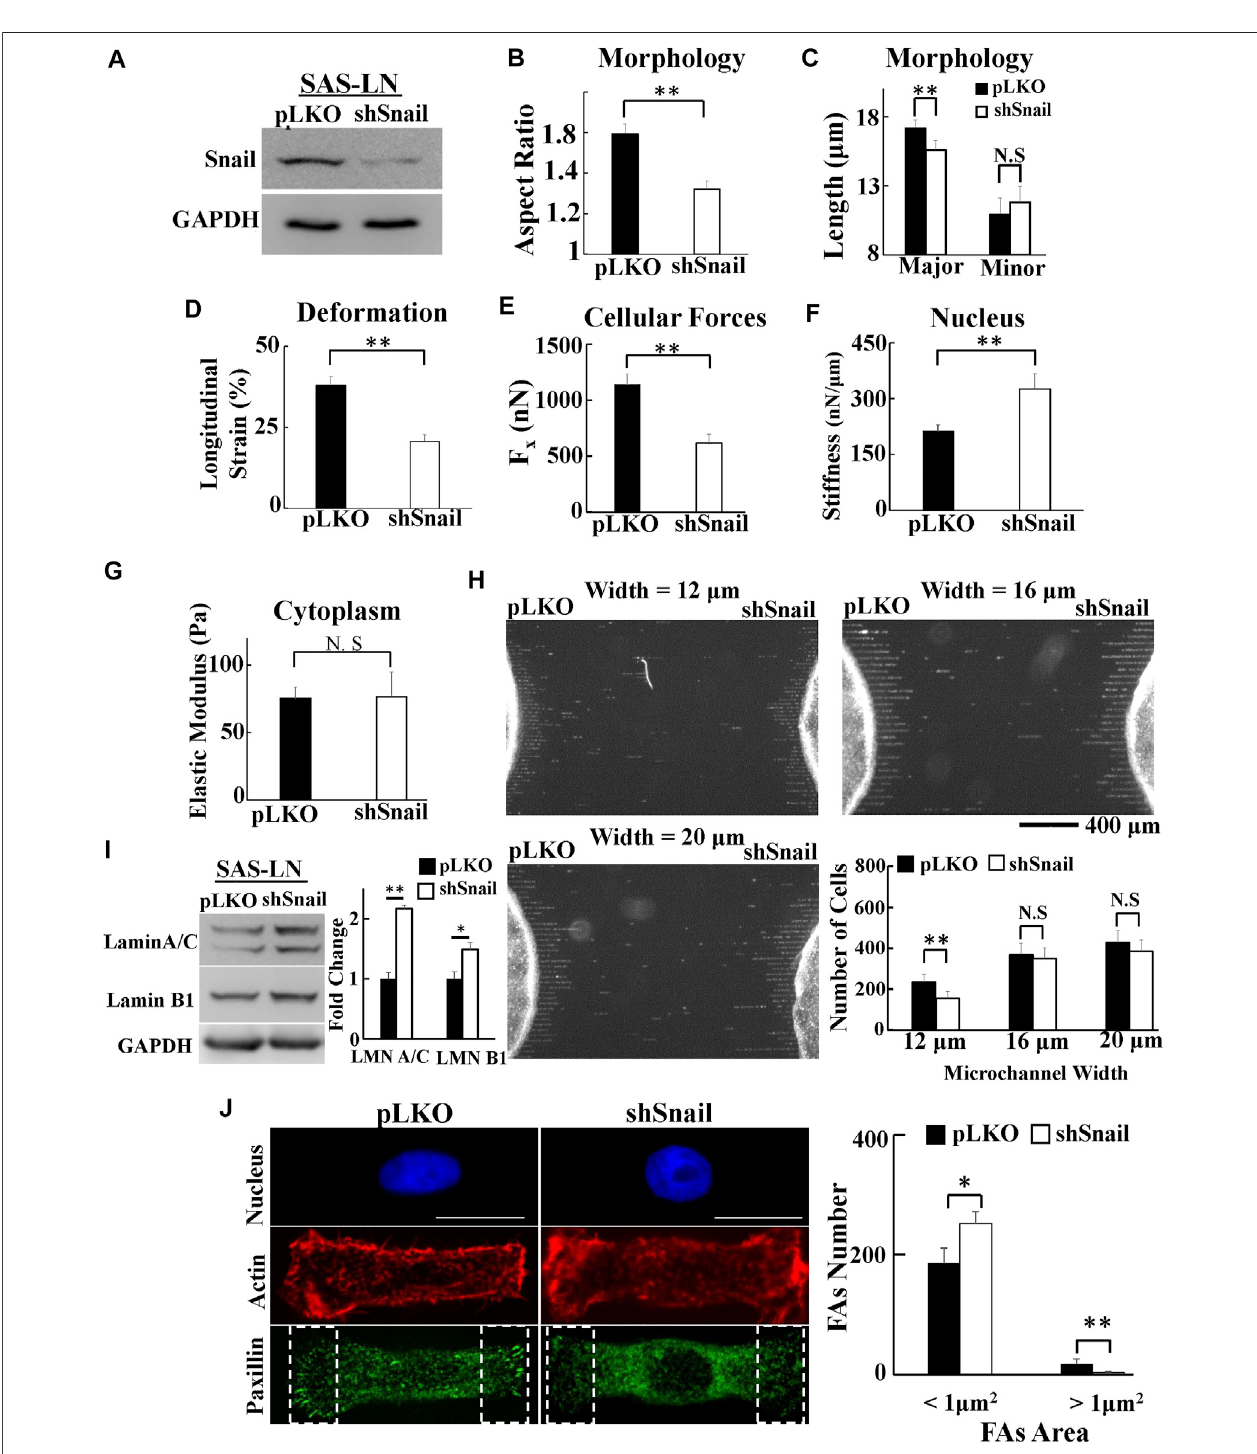
FIGURE6| TheeffectofSnail-knockdownonthebiomolecularandbiomechanical properties ofLN-metastatic HNSCCcells(SAS-LN). (A) WesternblotofSnail in control (SAS-LN-pLKO) using pLKO-shCtrl and Snail1-knockdown SAS-LN cells (SAS-LN-shSnail) using pLKO-shSnail, with GAPDH as a loading control. (B-C) Knockdown of Snail induced a round morphology of cell nuclei. (D-G) Knockdown of Snail reduced the longitudinal strain of cell nuclei and elongation forces (F x ), enhancednuclearstiffness,butrenderedsmallereffectoncytoplasmicstiffness.Datarepresentmean±SD(n=15). (H) ThenumbersofSAS-LN-shSnailandSAS- LN-pLKO cells, after invasion for 24hrs from the access ports into the microchannels (with different widths of 12, 16, and 20 μ m). To visualize and count the number of cells in the microchannels, the cell nuclei were stained with Hoechst 33342. The lower right panel shows the invasion capability of SAS-LN-shSnail and SAS-LN-shluc